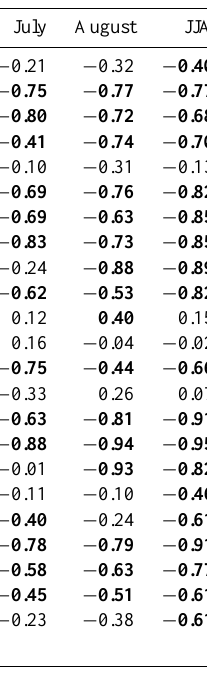
Table 2. Correlation between ice albedo and surface temperature, averaged over 80 ◦ N–90 ◦ N. Correlations that are significant at the 95% significance level are marked